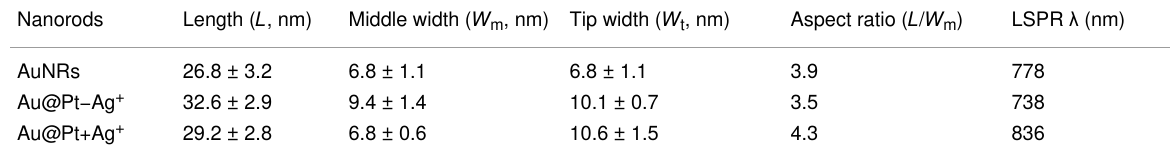
Table 1: Dimensions and optical properties of AuNRs, Au@Pt − Ag + , and Au@Pt+Ag +